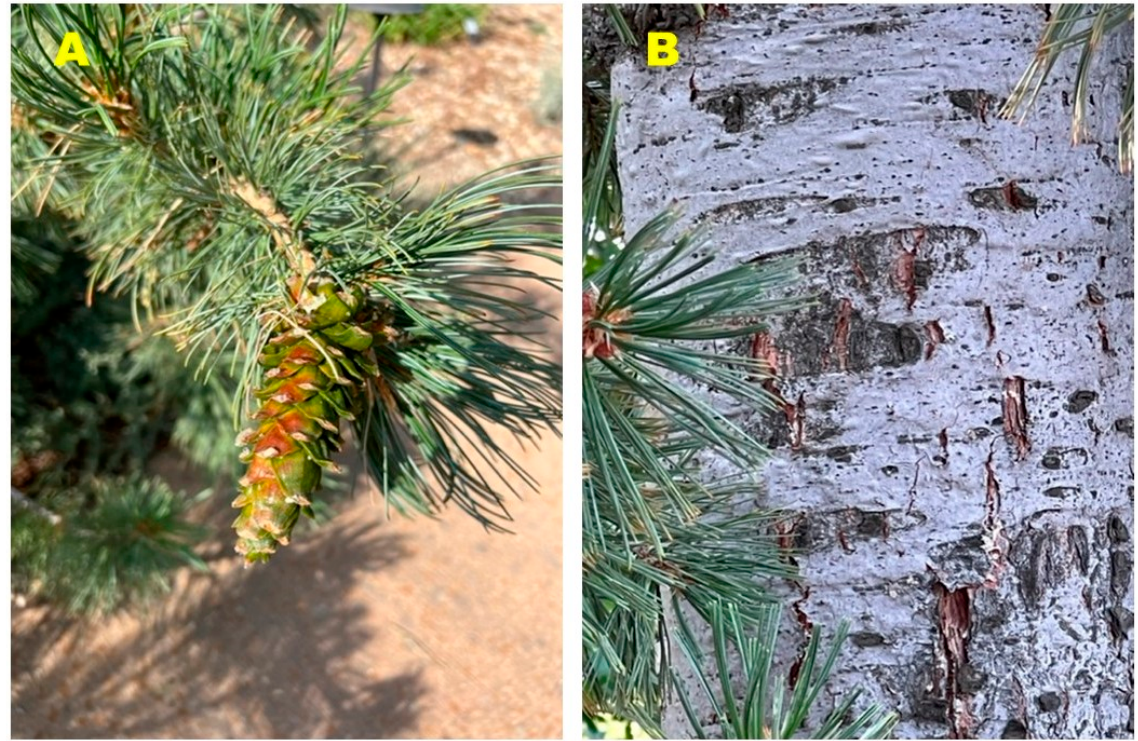
Figure 3. Pinus flexilis from southwestern Idaho. ( A ) Leaves (needles) and cone. ( B ) bark.